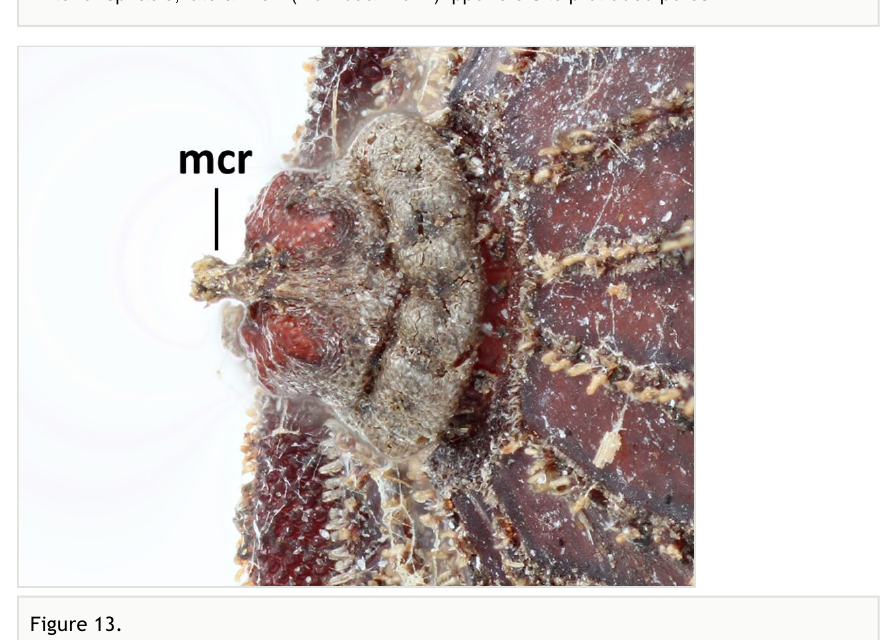
Figure 12. Anterior spiracle, lateral view (individual No. 2). ppo refers to protruded pores.